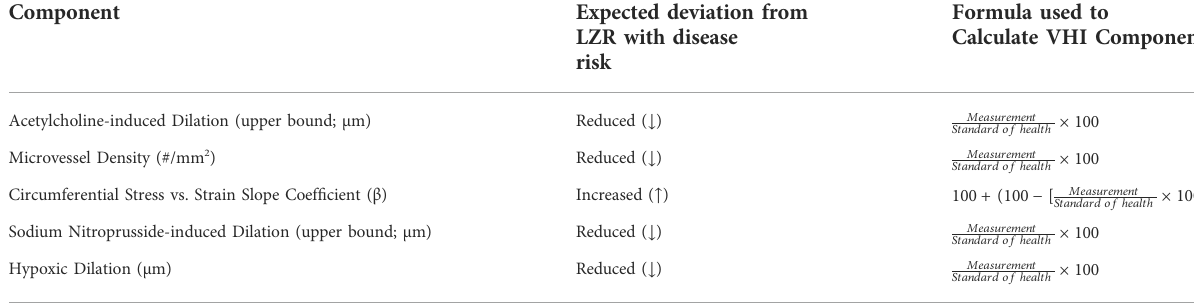
TABLE 1 Calculations used for the determination of individual VHI Components in the present study.